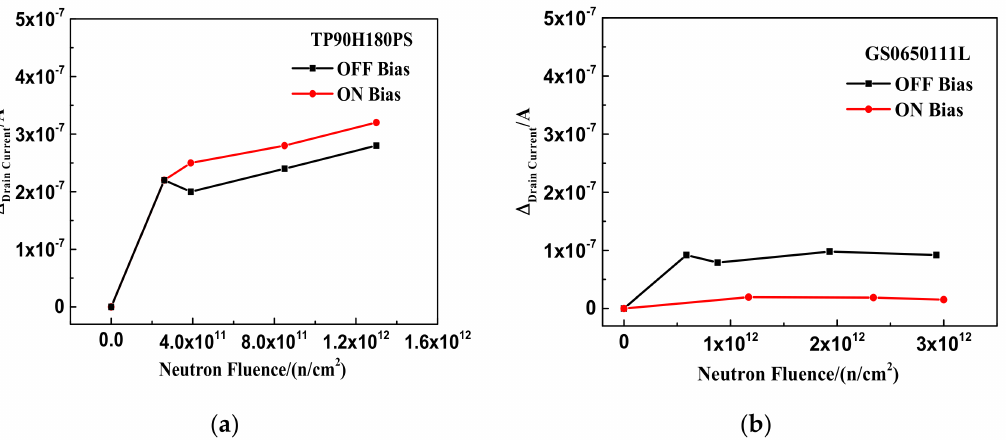
Figure 3. The relationship between the leakage current variations of the device and the neutron irradiation under the on-state and off-state: ( a ) TP90H180PS and ( b )